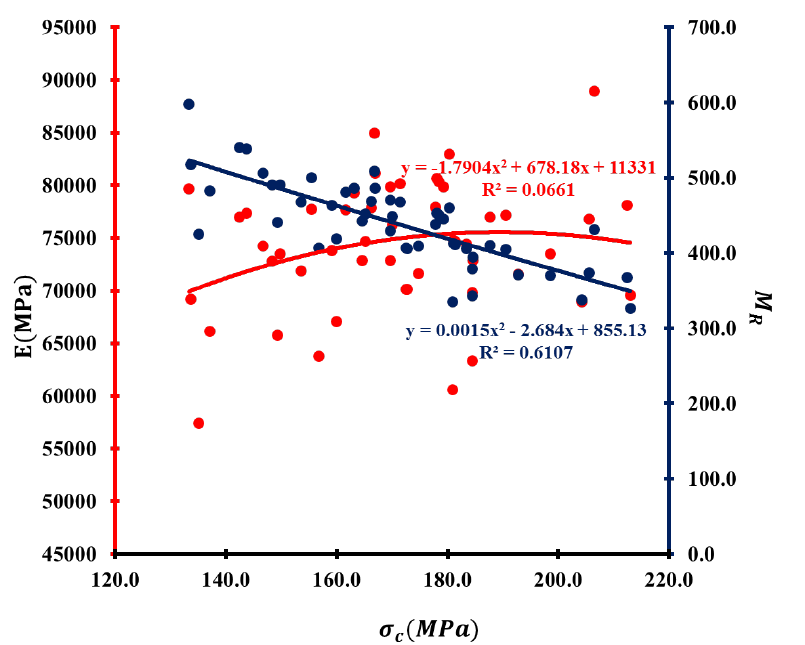
for all studied R